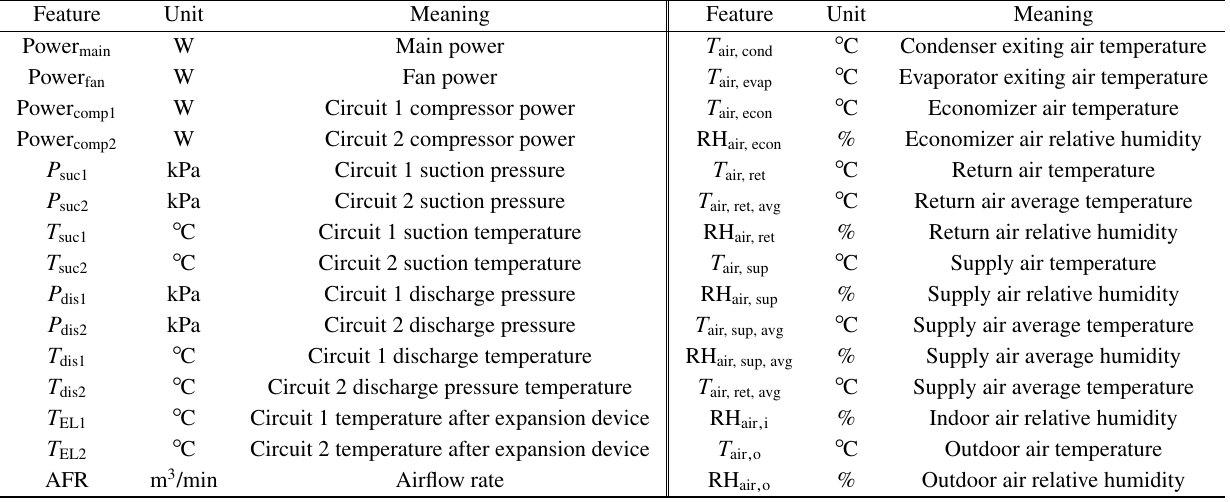
Table 3 List of measured input variables (features) for the RTU that used to develop the proposed FDD methods. Feature